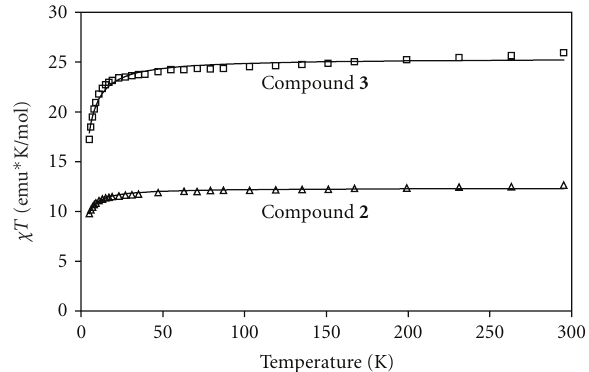
Figure 6: Temperature dependence of magnetic susceptibilies for compounds 2 and 3 (5–300 K at 1000